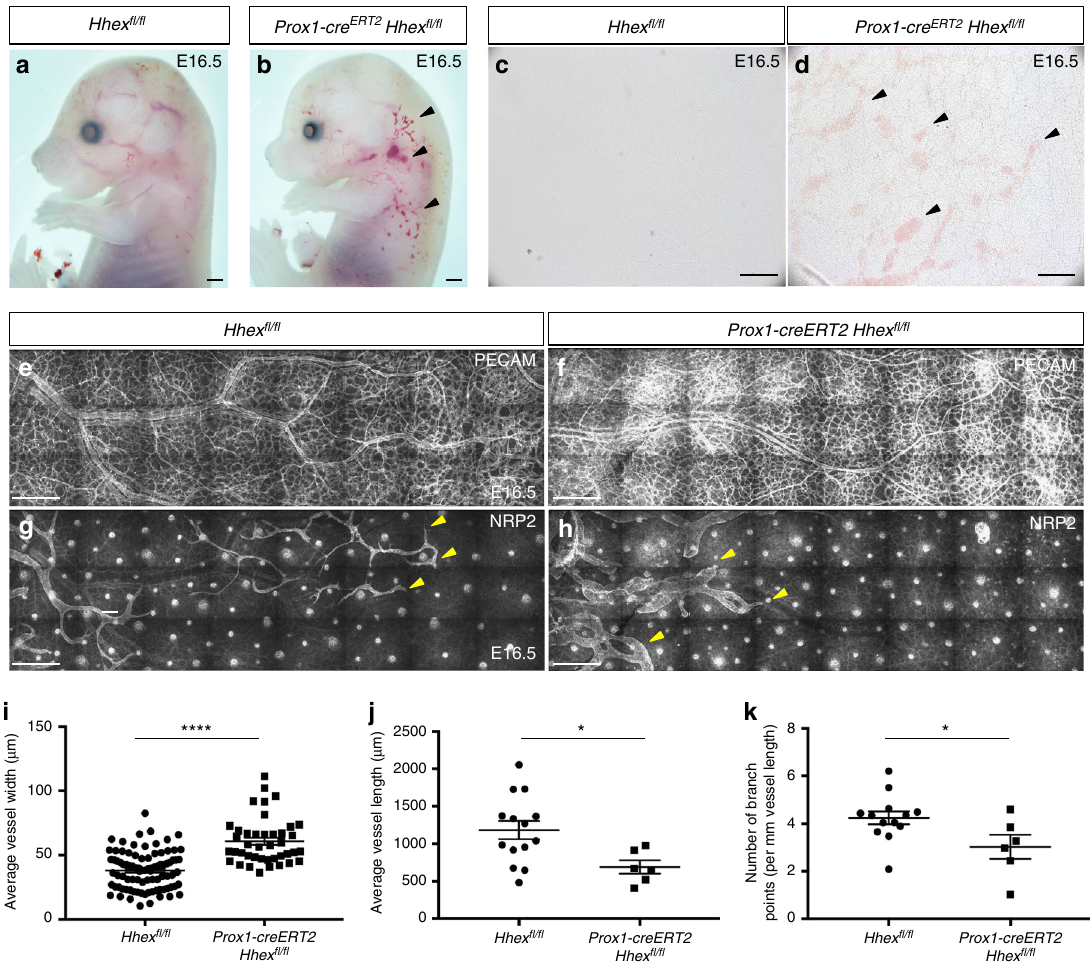
Fig. 8 Prox1-cre ERT2 Hhex fl / fl mouse embryos exhibit lymphatic defects at E16.5. a , b Whole-mount views of Hhex fl / fl and Prox1-cre ERT2 Hhex fl / fl embryos at E16.5 after tamoxifen injection at E10.5, 11.5, and 12.5. Hhex deletion in Prox1 -expressing cells leads to lymphatic defects including edema and blood- fi lled lymphatics (arrowheads). c , d Bright fi eld pictures of Hhex fl / fl and Prox1-cre ERT2 Hhex fl / fl skin at E16.5. Hhex mutants exhibit blood- fi lled lymphatics (arrowheads). e – h Whole-mount views of Hhex fl / fl and Prox1-cre ERT2 Hhex fl / fl skin at E16.5 after PECAM ( e – f ) and NRP2 ( g , h ) immunostaining. Hhex mutants do not exhibit vascular defects but clear lymphatic defects (arrowheads point to lymphatic vessels). i – k Quanti fi cation of the lymphatic network including average vessel width ( i ), average vessel length ( j ), and number of branch points (per mm vessel length) ( k ) in Hhex fl / fl ( n = 3) and Prox1-cre ERT2 Hhex fl / fl ( n = 3) skin at E16.5. Values represent means ± s.e.m. **** P ≤ 0.0001 and * P ≤ 0.05 by t -test. Scale bars: 1 mm ( a , b ), 200 μ m ( c , d ), and 250 μ m ( e – h